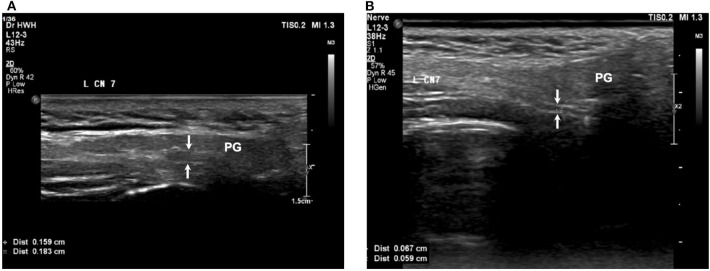
The facial nerve size subsided with time in a patient with MFS. (A) Before treatment, (B) 90 days after treatment. Arrows: facial nerve; PG, parotid gland.